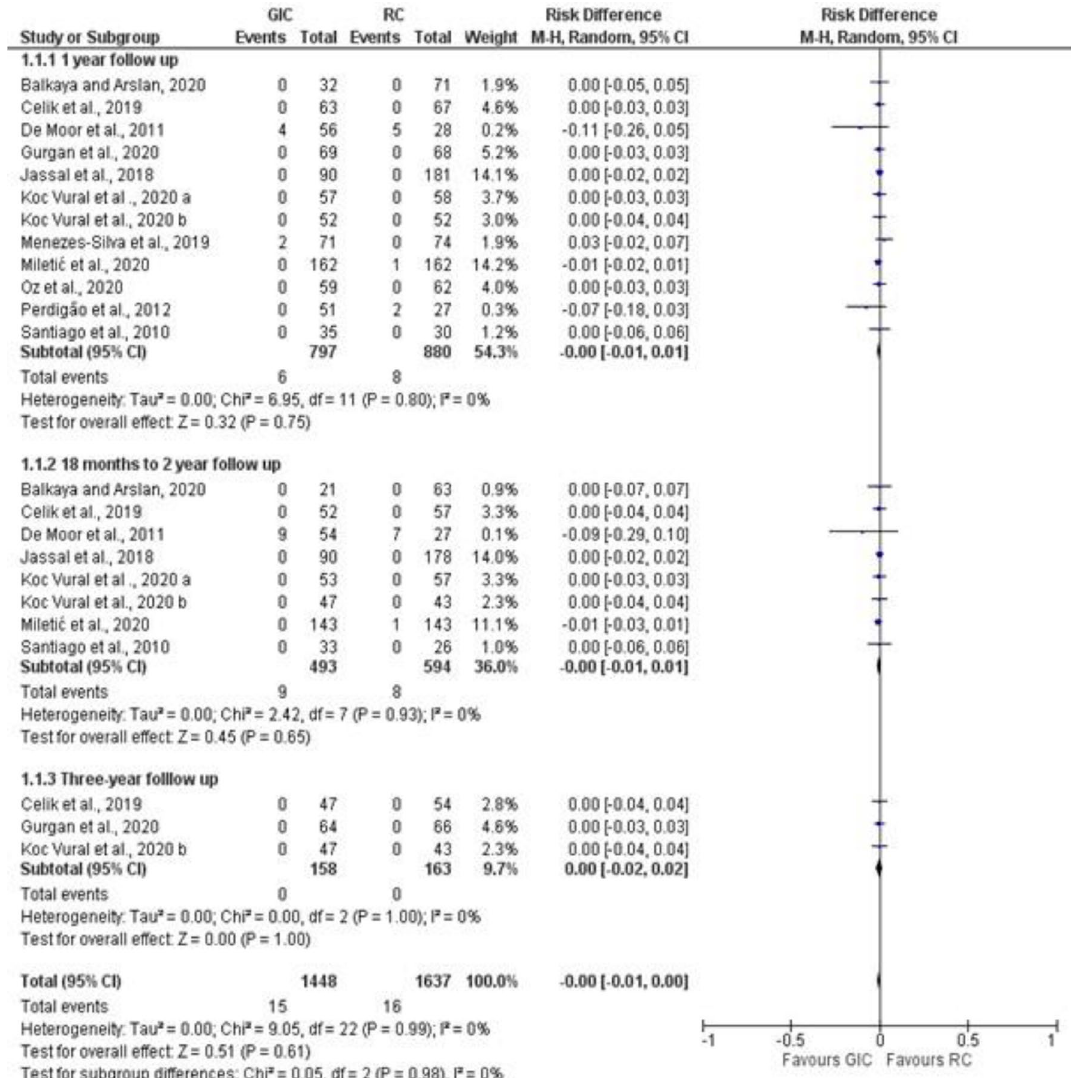
Figure 3. Forest plot of comparison: Ion releasing restoration (GIC) versus resin composite, outcome: 1.1 Secondary caries for all types of cavities.